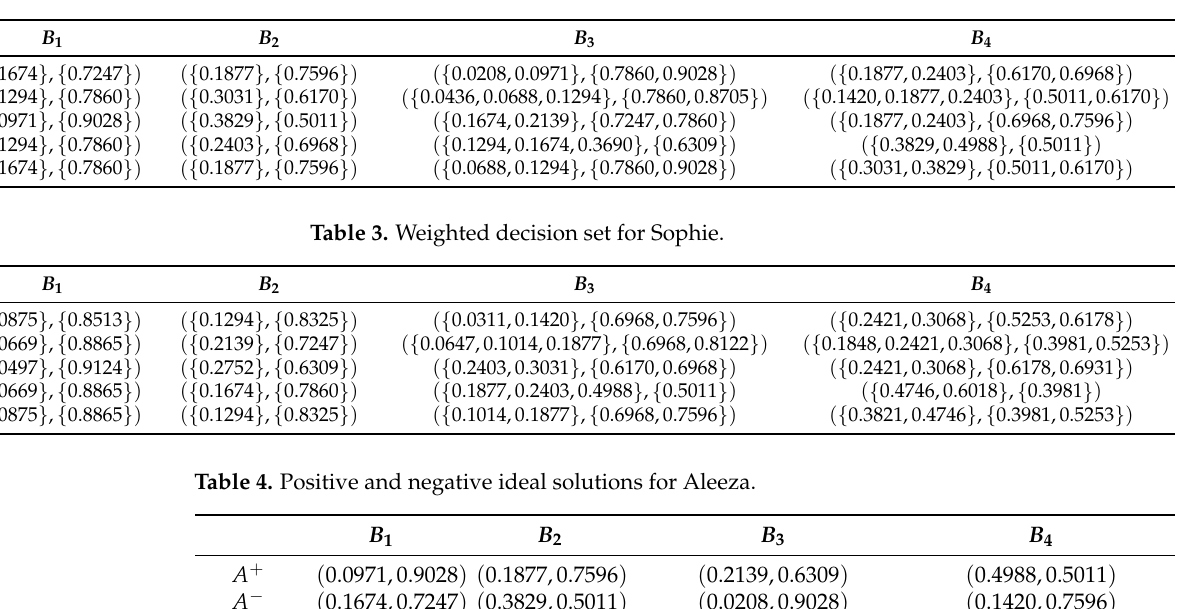
Table 2. Weighted decision set for Aleeza.